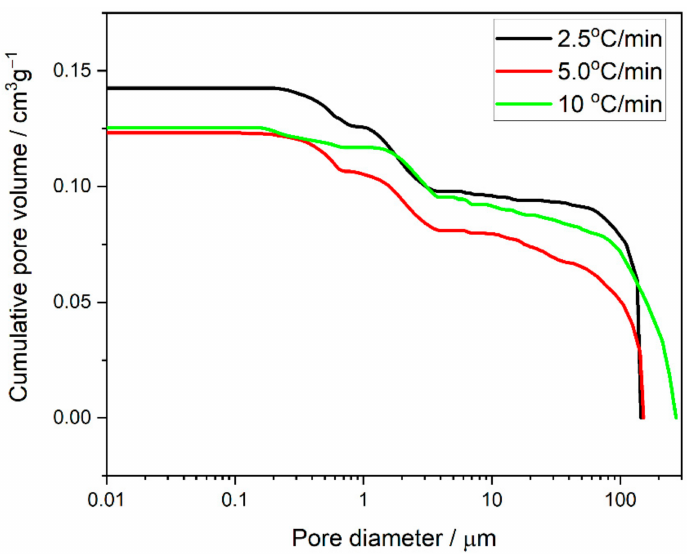
Figure 12. Cumulative pore volume vs. pore diameter recorded for the Ni–5CBCY